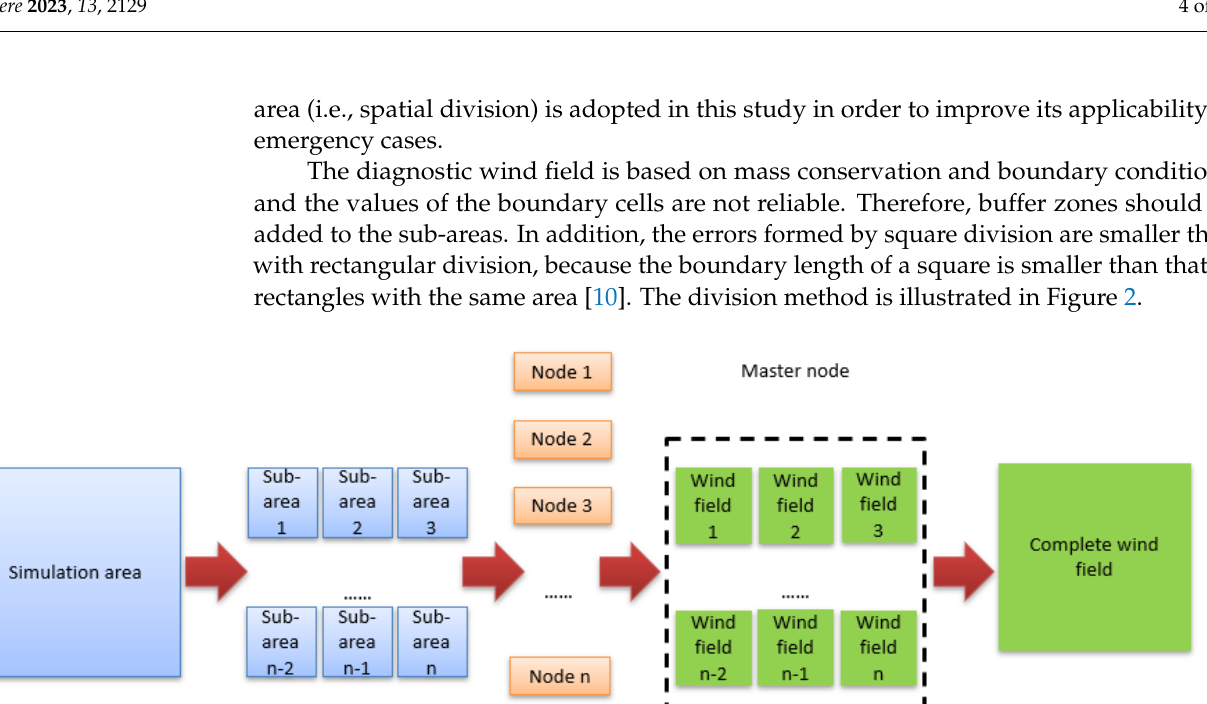
Figure 2. Parallelization method for the CALMET module.